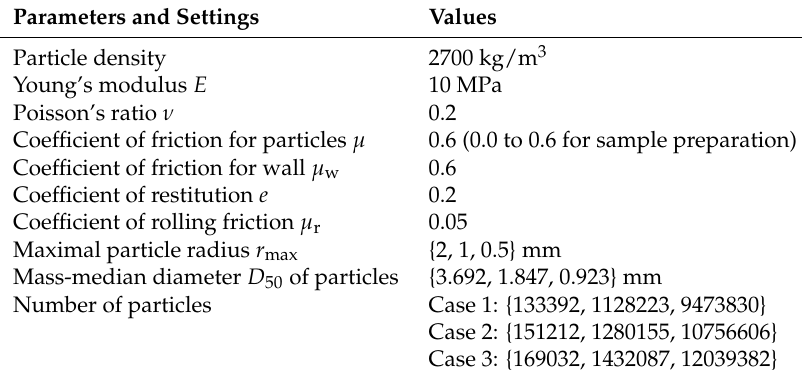
Table 2. Parameters and settings used in the discrete element